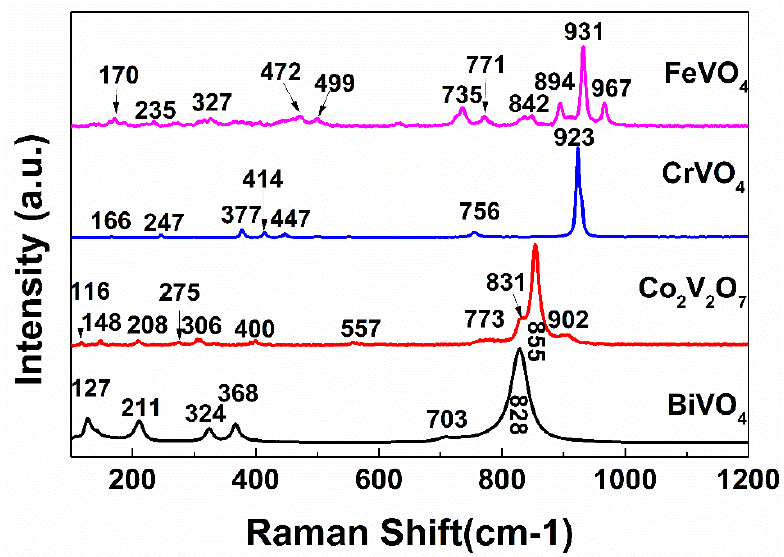
Figure 4. Raman spectra of BiVO 4 , FeVO 4 , CrVO 4 , and Co 2 V 2 O 7 . Materials 2020 , 13 , 1628